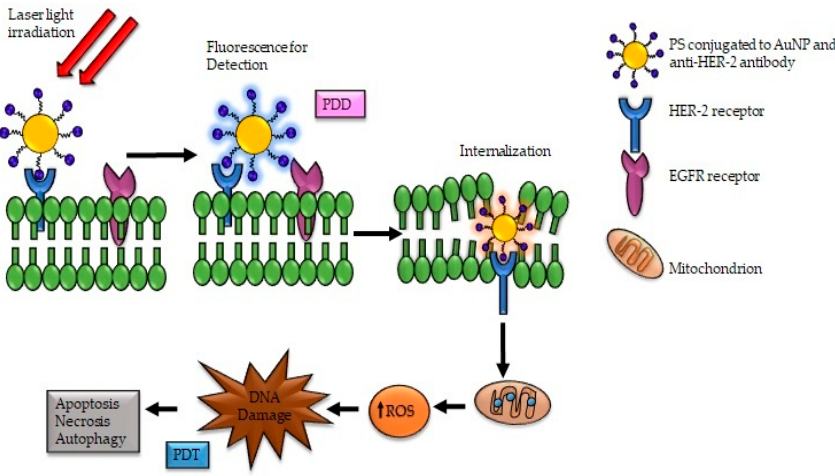
Figure 4. Antibody-based AuNP binding to the HER-2 receptor expressed in esophageal cancer cells promotes easy detection and diagnosis of esophageal cancer.